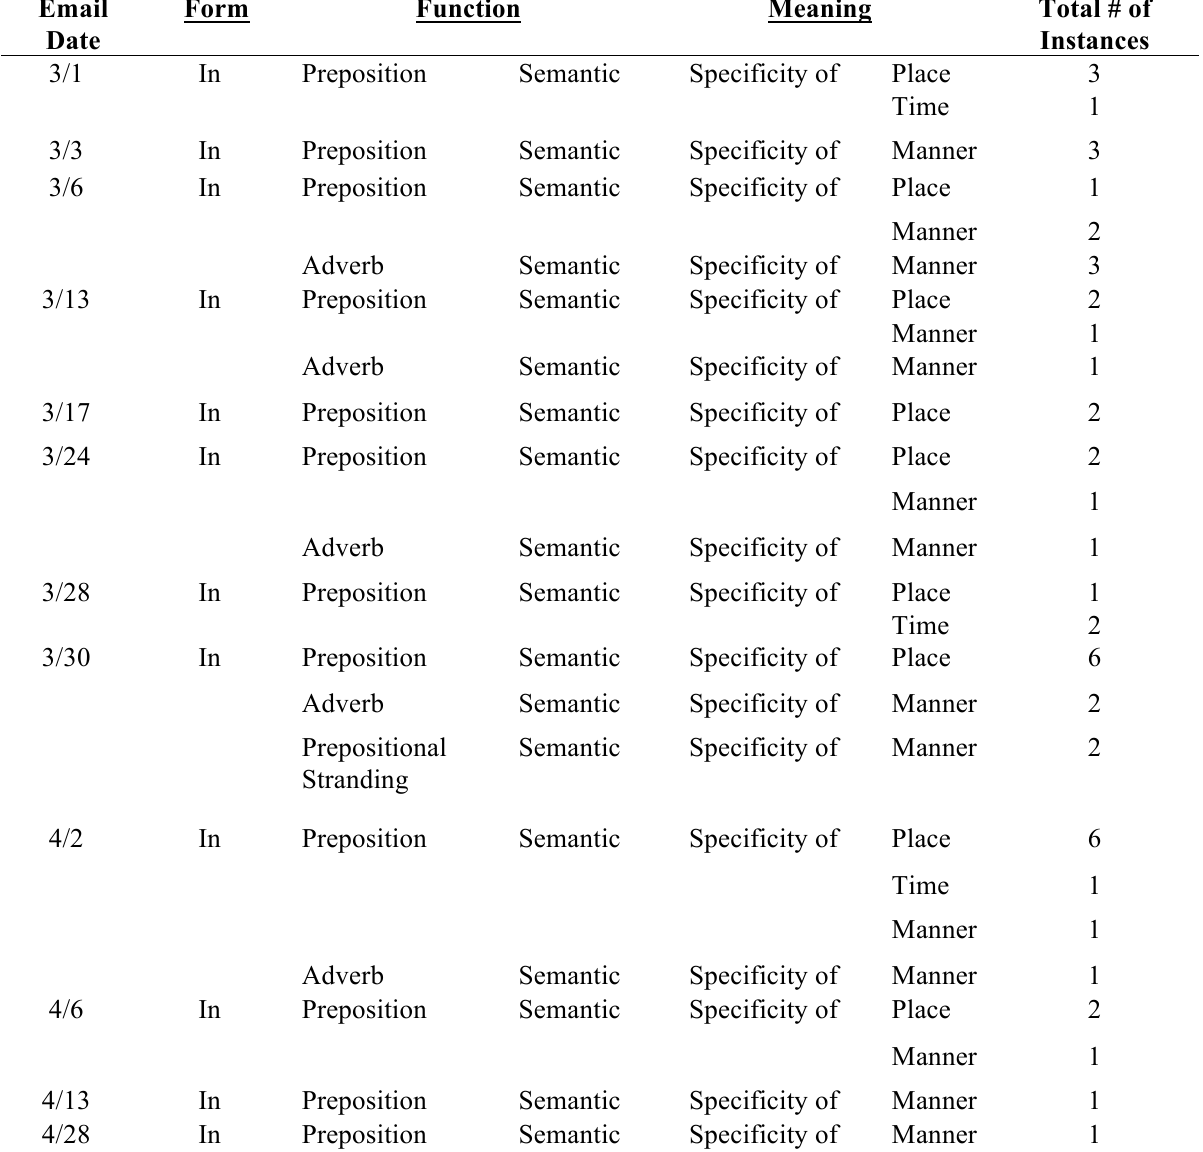
Form-function analysis: Michelle “in”